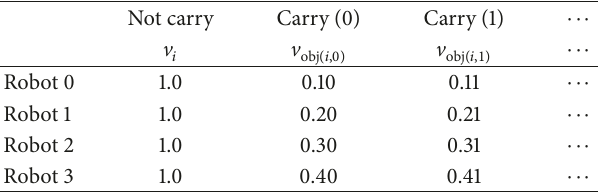
Table 11: Moving